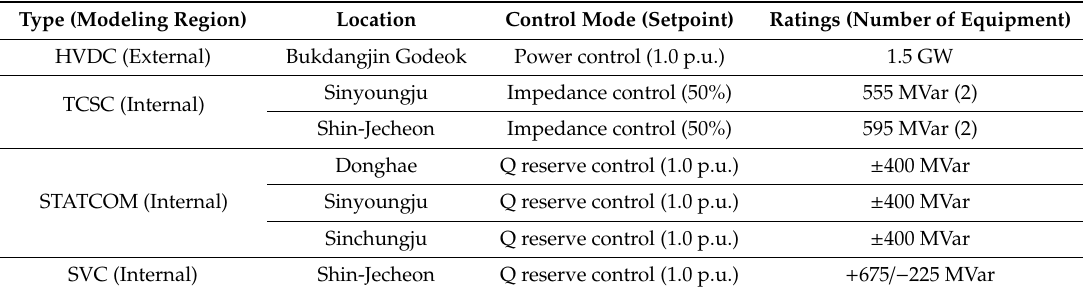
Table 2. Power electronics equipment in the test case. SVC, Static VAR Compensator.